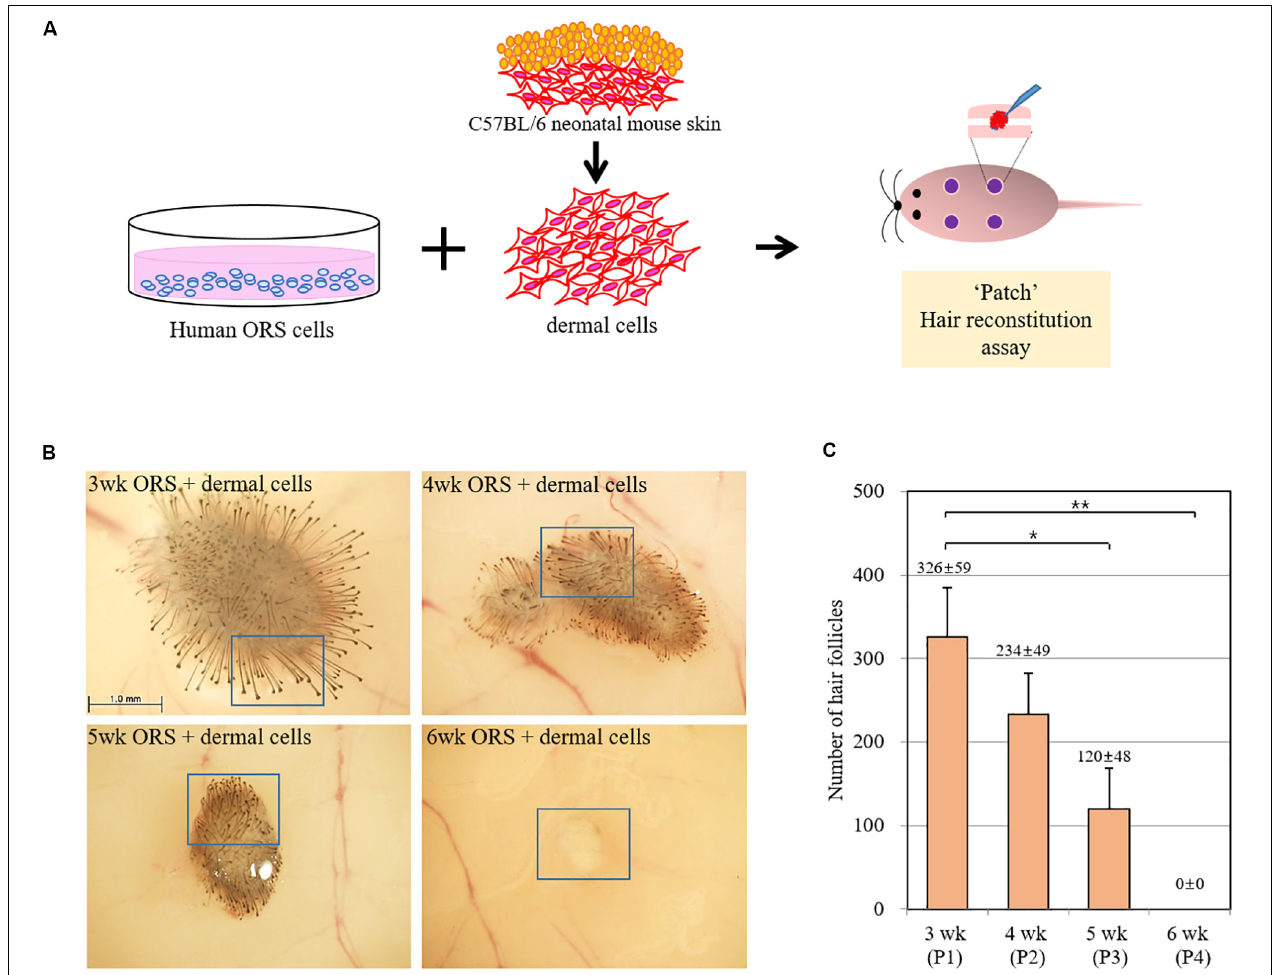
FIGURE 2 | Inverse correlation of hair-inductive activity of ORS cells with their cultivation period. (A) Diagram of a “patch” hair reconstitution assay used in this study. Cultured human ORS cells (1 × 10 6 cells) were combined with freshly isolated neonatal mouse dermal cells (1 × 10 6 cells) and then subcutaneously implanted into the skin on the backs of 7-week-old female nude mice. (B) Hair follicle (HF) formation was examined from the back skin of the mice after 2 weeks and representative pictures are shown. High power images of boxed regions are shown in Supplementary Figure S2 . (C) Total induced HFs were quantified and the data are the means ± standard deviation of four determinations using same batch ORS cells from a patient (male, age 26 years). * P < 0.05, ** P <